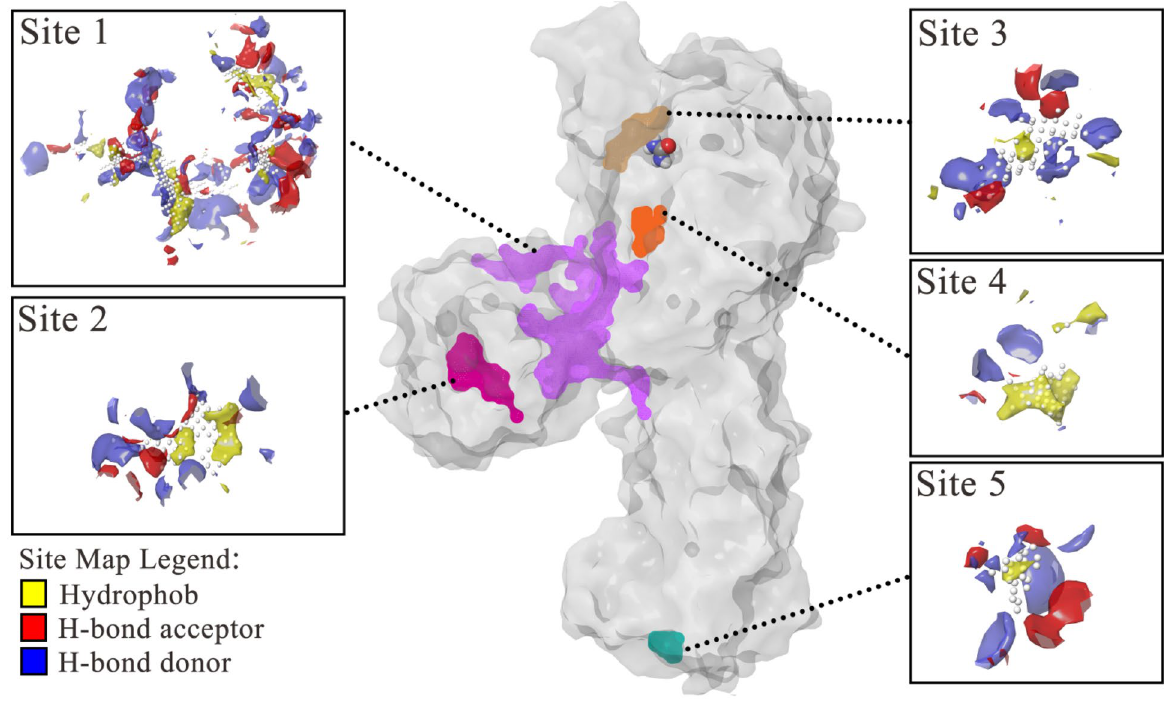
Figure 6. Potential binding sites of jack bean urease detected by sitemap. In each site’s magnified image the hydrophob (yellow), H-bond acceptor (red), and H-bond donor (blue) parts have been